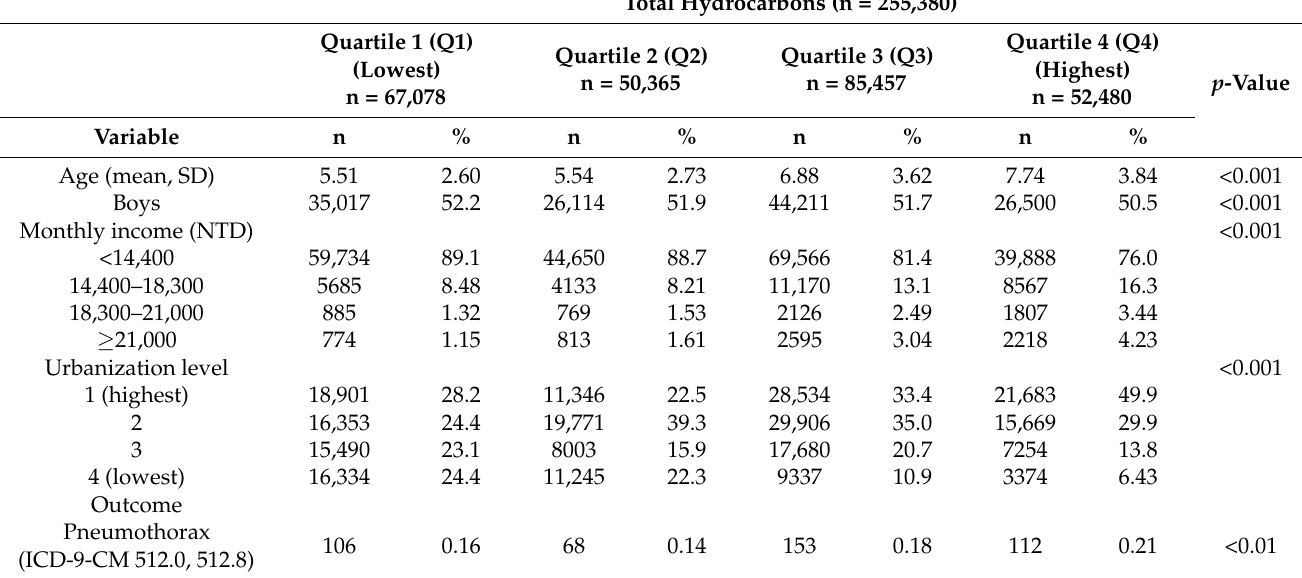
Table 3. Characteristics of participants exposed to various annual average concentrations of total hydrocarbons. Total Hydrocarbons (n = 255,380)